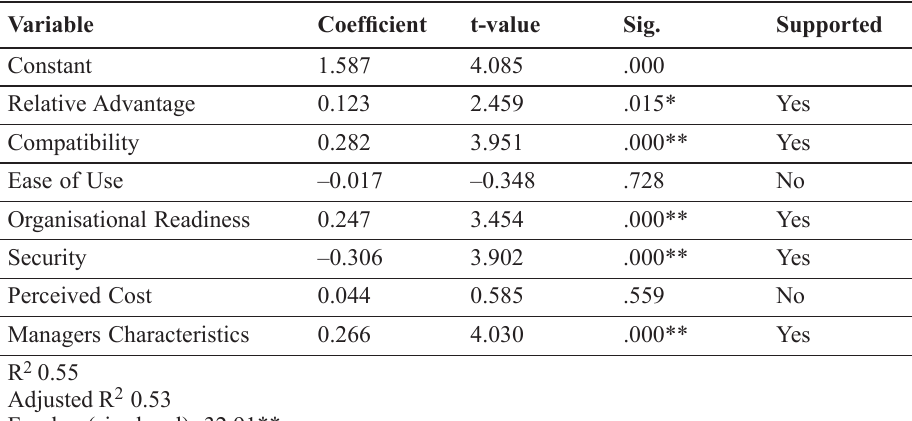
Table 4. Multiple Regression